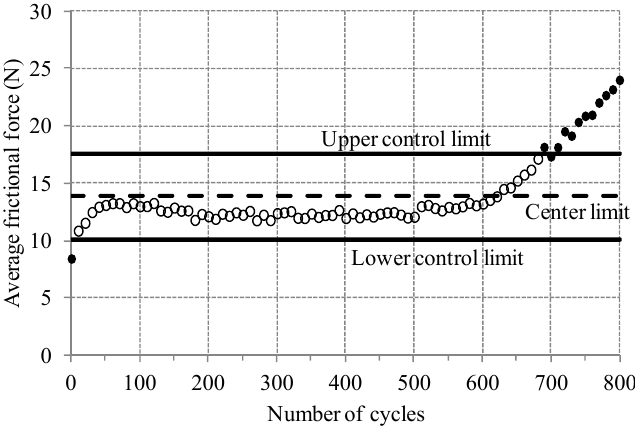
Figure 5. Evolution of the average frictional force and control limits.